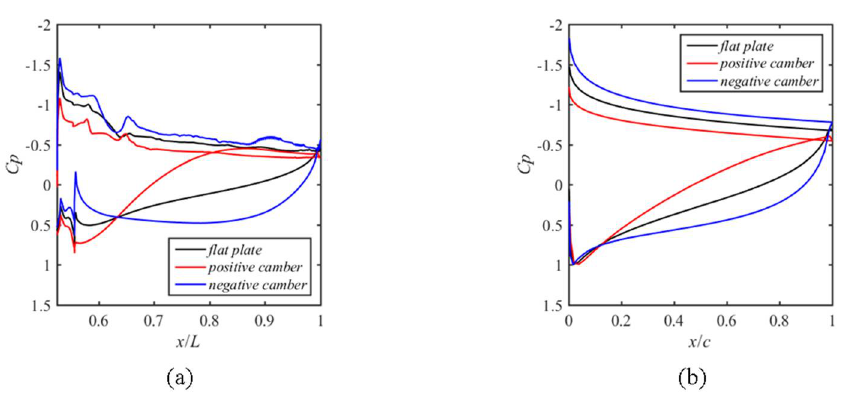
Figure 6. Pressure coefficient of the blade at α = 0°. ( a ) Blade of the shuttle cock; ( b ) Two-dimensional flat